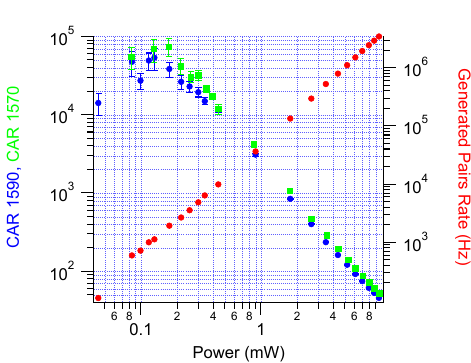
Fig. 4. Measured Coincidence to accidental ratio (Blue Symbols for pump at 887nm and pressure 4.75 Bar to work with the 1590nm output of the CWDM filter, and Green Symbols for pump at 895nm and pressure 9.25 Bar to work with the 1570nm output) and rate of pairs generated at fibre output (Red Symbols) as a function of the mean pump power.